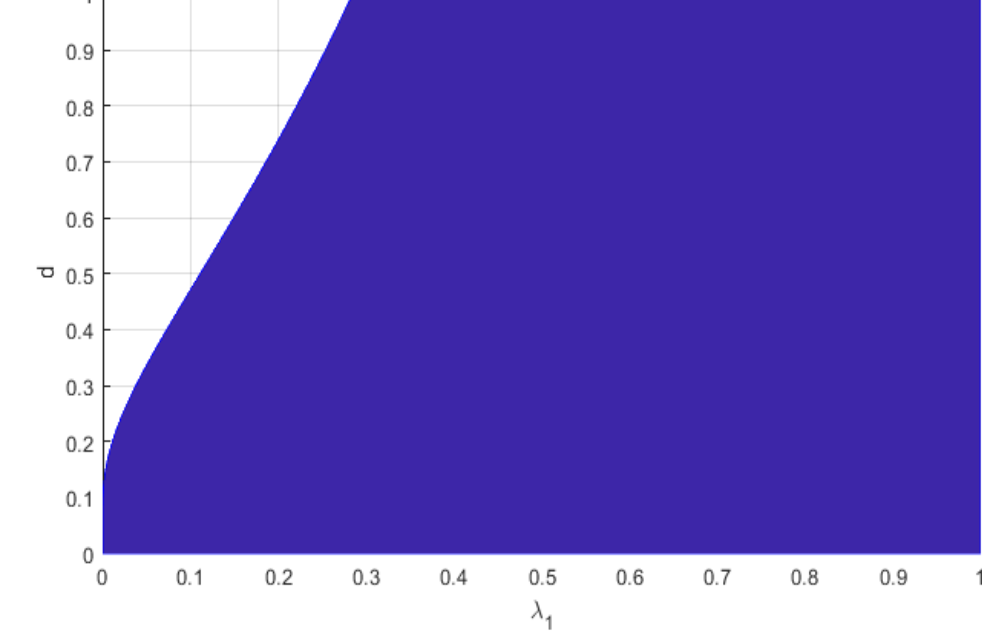
Figure 2. Region when Inequality (29) is